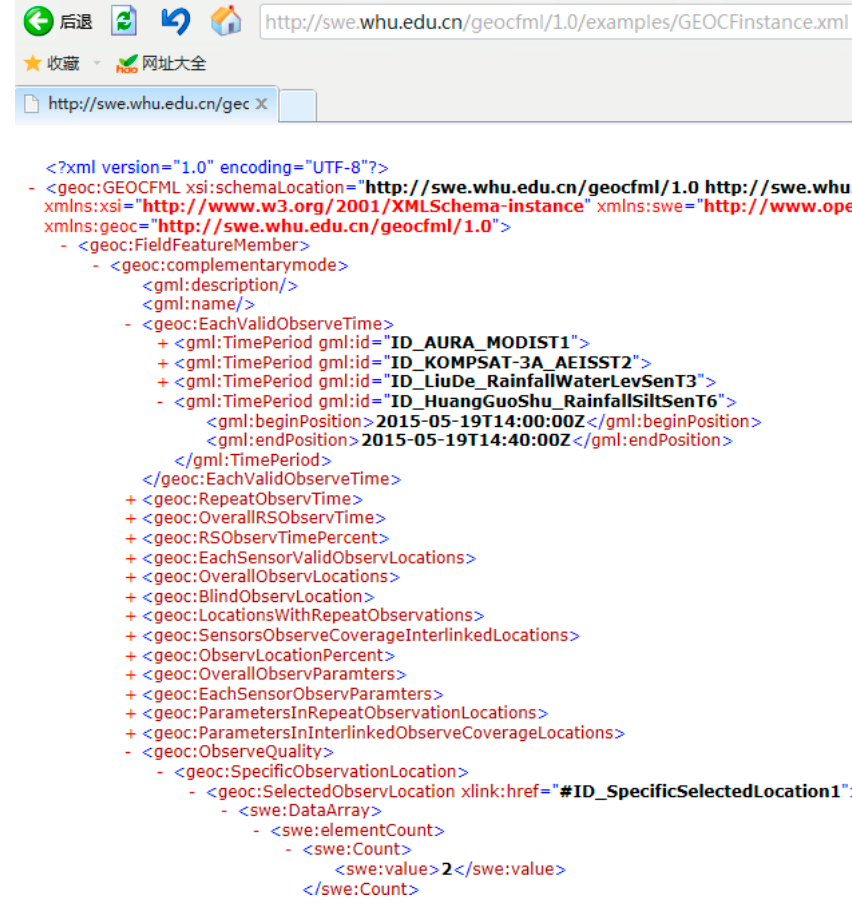
Figure 14. A sample of the GEOCF information representation model.